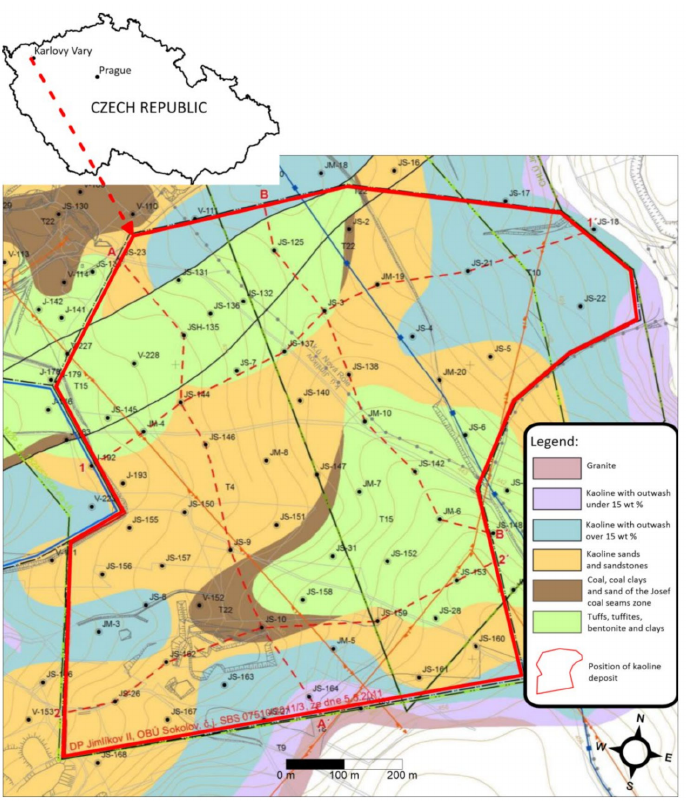
Figure 1. Available historical drill holes of the area of interest based on a geological map according to